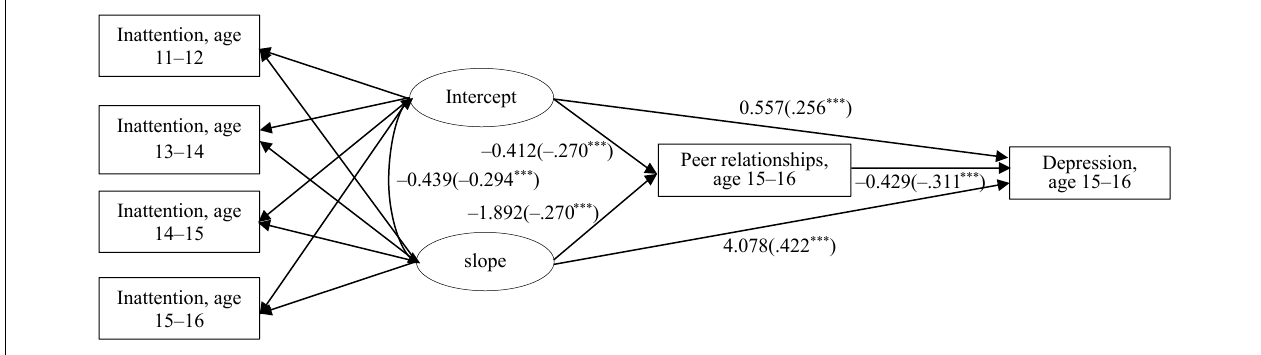
FIGURE 2 | Results of latent growth modeling (LGM) (Panel 2). Peer relationship at age 15–16 and depressive symptoms at age 15–16 were controlled for child sex. Parameters in parentheses are standardized coefficients. *** p <